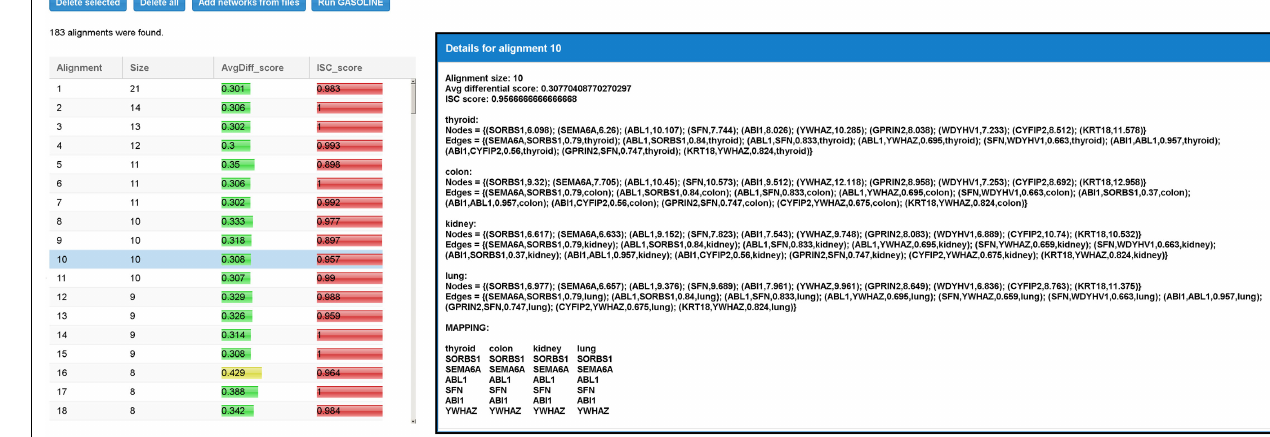
FIGURE 9 | Result table for the differential local alignment of the four TS-PPI networks of Figure 8 with the Adaptive GASOLINE . The table reports, for each alignment, the size (i.e., the number of aligned nodes), the average expression difference between aligned nodes, and the ISC (Index of Structural Conservation) score. When the user selects a row in the table, a panel with alignment details is shown to the right. Details include the list of aligned